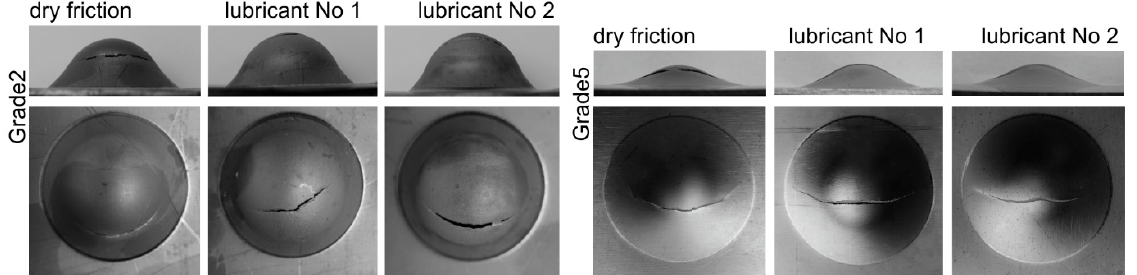
Figure 5. View of sheet surface with layer of lubricant No 2 sprayed on: ( a ) Grade 2 titanium sheet; ( b ) Grade 5 titanium sheet after strip drawing test.